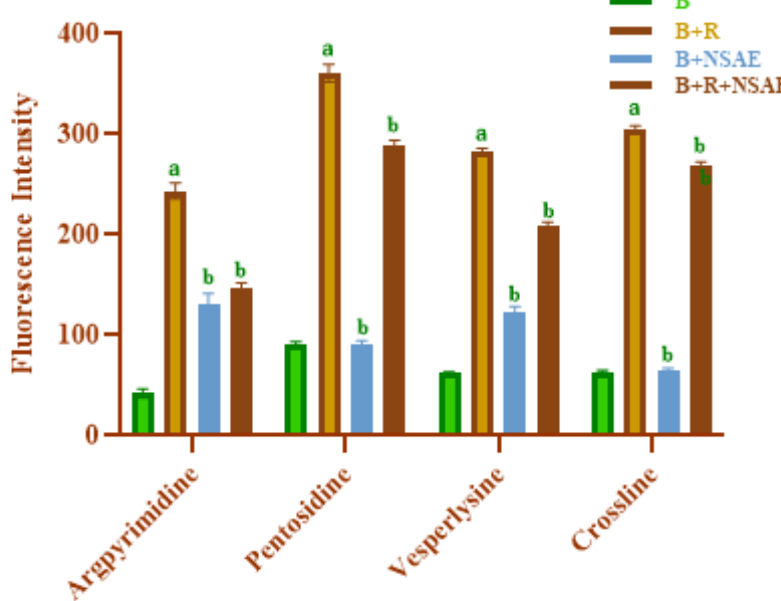
Figure 9. Nigella sativa aqueous extract (NSAE) affects individual AGEs formation in the BSA+D- ribose system. Results are represented as mean ± SD ( n = 5). a p < 0.05 when compared to BSA and b p < 0.05 when compared to BSA+D-ribose.